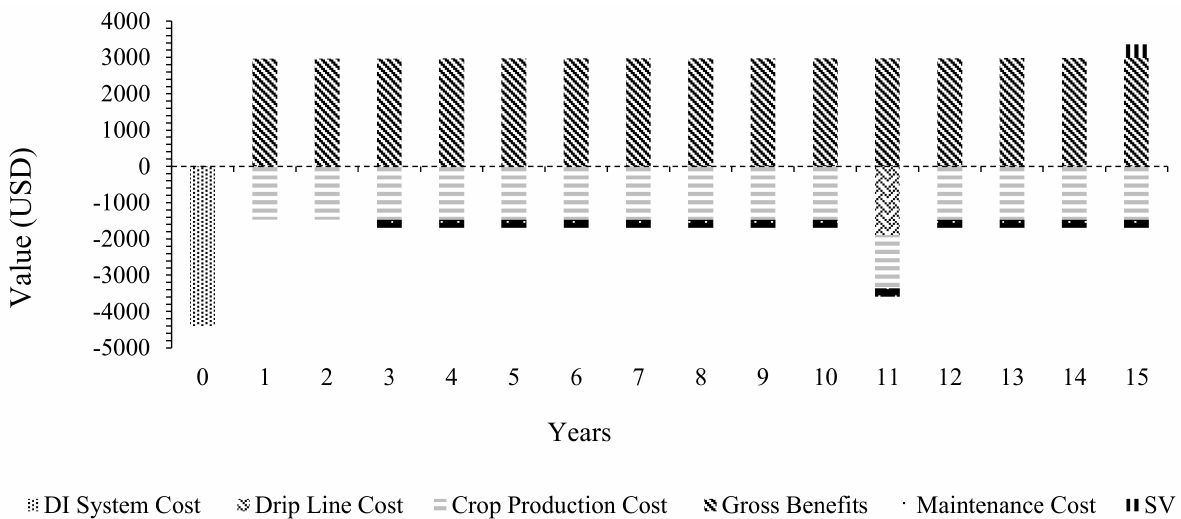
Figure 7. Cashflow diagram for diesel power drip irrigation